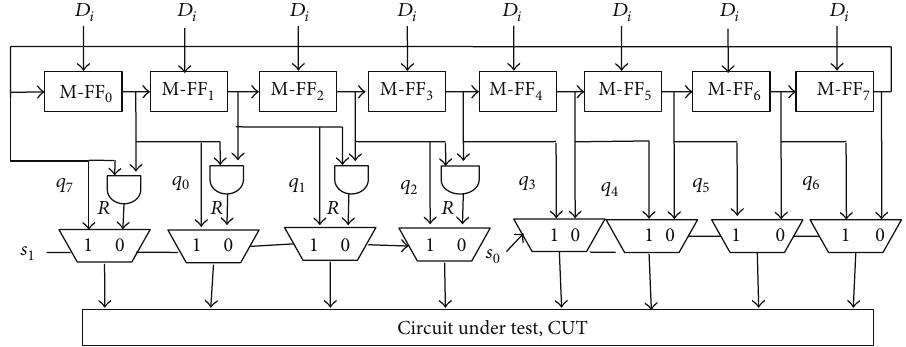
Figure 7: Implementation of proposed method.